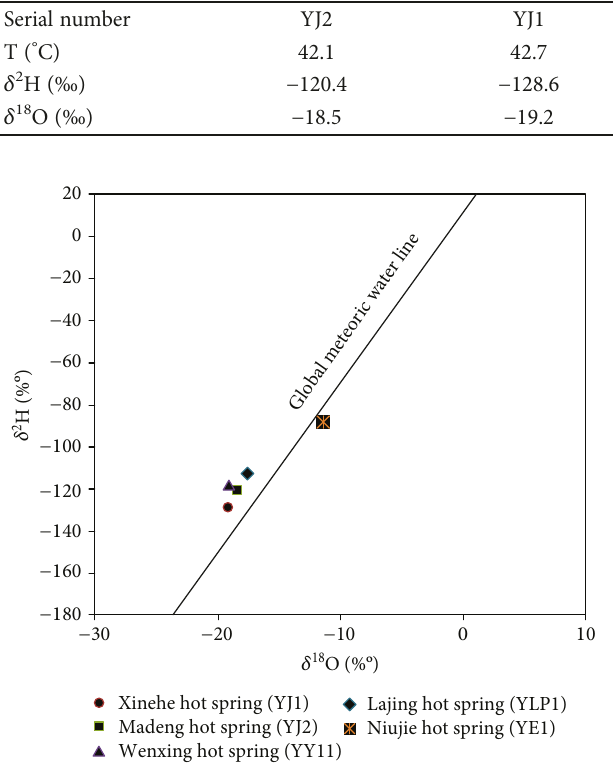
Figure 3: Plot of δ 2 H- δ 18 O of the hot water samples.